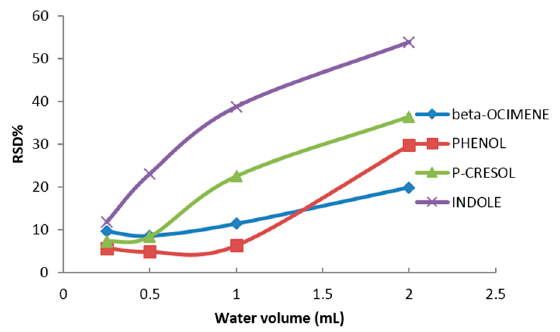
Figure 7. Influence of water volume added to encapsulated product on the repeatability of the method in terms of RSD%.